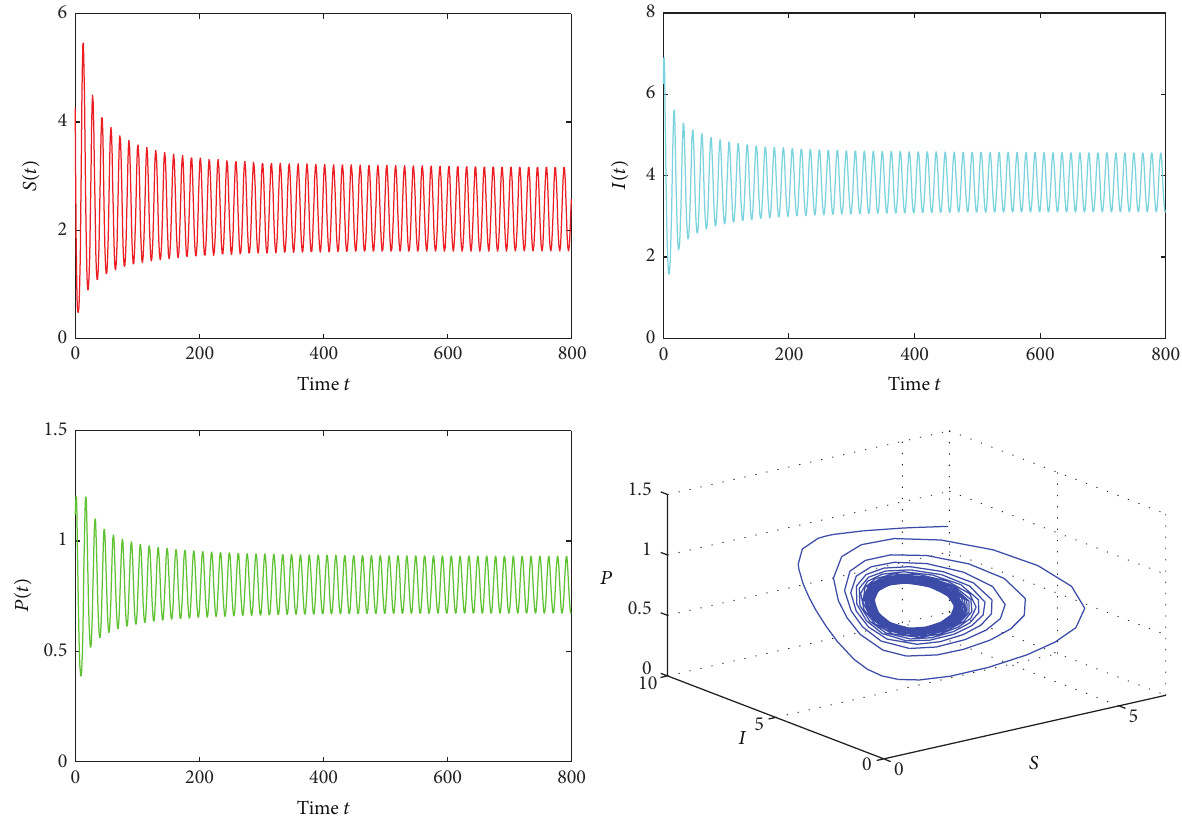
Figure 8: 𝐸 ∗ is unstable when 𝜏 2 = 1.35 > 1.0782 = 𝜏 ∗ 20 and 𝜏 1 = 0.15 ∈ (0,𝜏 10 )